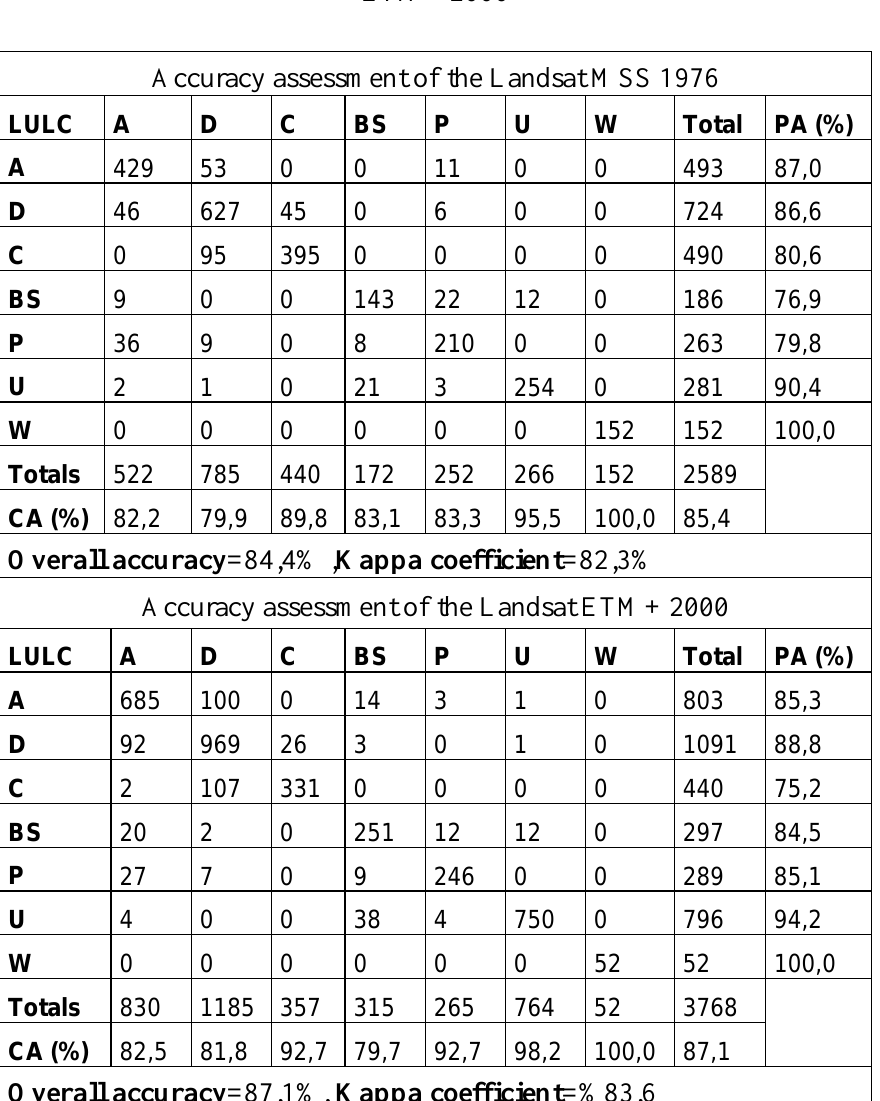
Table 2. Accuracy assessment for supervised classification of Landsat MSS 1976 and Landsat ETM+